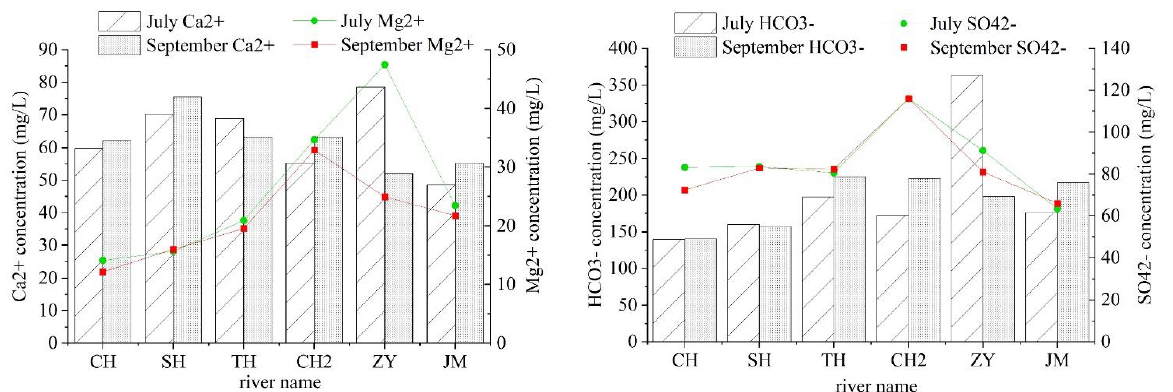
Figure 7. Average concentrations of main cations and anions in the surface water of the mountain-